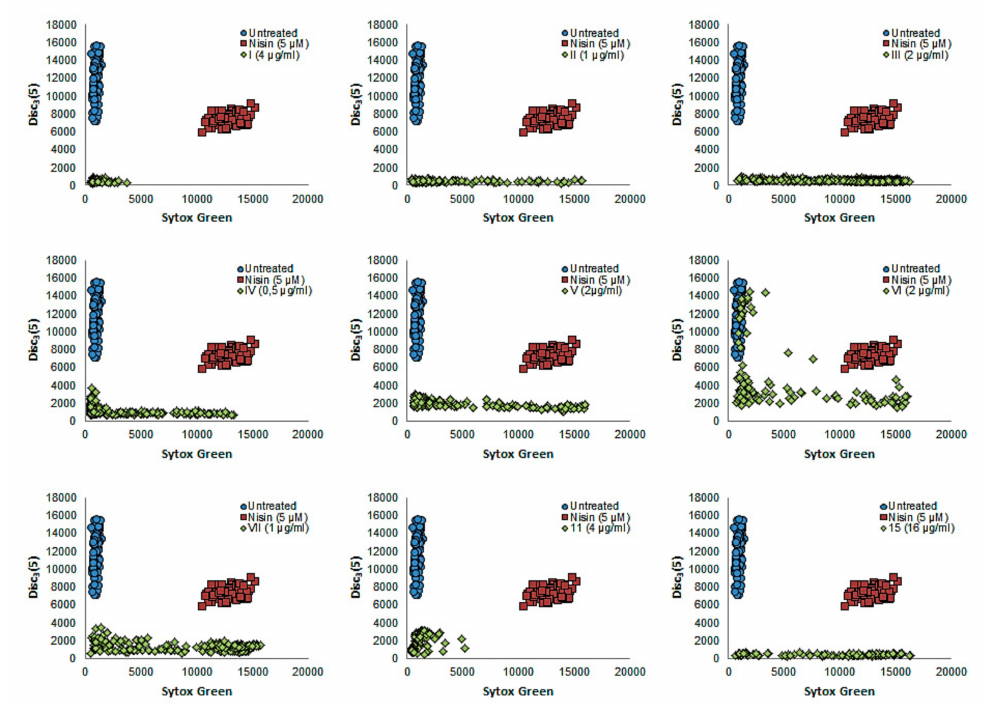
Figure 6. Depolarization and pore formation of B. subtilis WT168 induced by cationic imidazolium- containing dendritic systems. Bacteria treatment with: (blue) sterile distilled water; (red) Nissin as pore formation standard; (green) dendritic system.